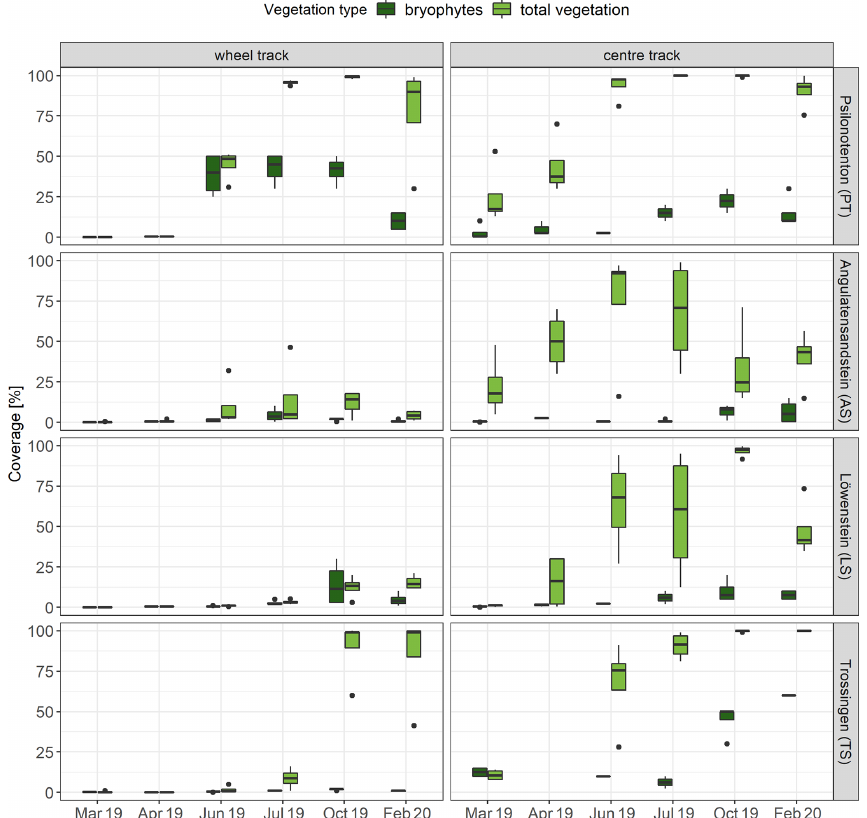
Figure 3. Development of bryophyte ( n = 4) and total vegetation coverage ( n = 4) per runoff plot at the individual skid trails. The bottom and top of the box represent the first and third quartiles, and whiskers extend up to 1.5 times the interquartile range (IQR) of the data. Outliers are defined as more than 1.5 times the IQR and are displayed as